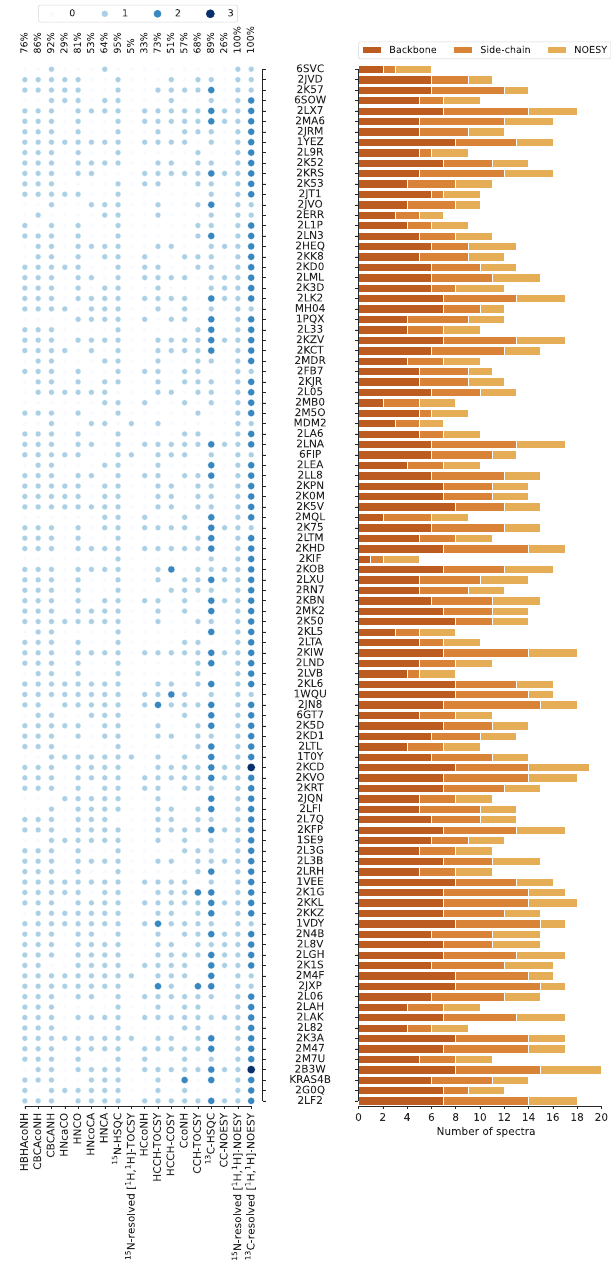
Fig. 2 | NMR benchmark dataset content. PDB codes (or names, MH04, MDM2, KRAS4B,ifPDBcodeunavailable)ofthe100benchmarkproteinsareorderedbythe number of residues. The histogram shows the number of spectra for backbone assignment,side-chainassignment,andNOEmeasurement.Spectrumtypesineach data set are shown by light to dark blue circles indicating the number of individual spectra of the given type. The percentages of benchmark records that contain a given spectrumtypearegivenatthe top.Spectrum typespresent in lessthan5%of the data sets have been